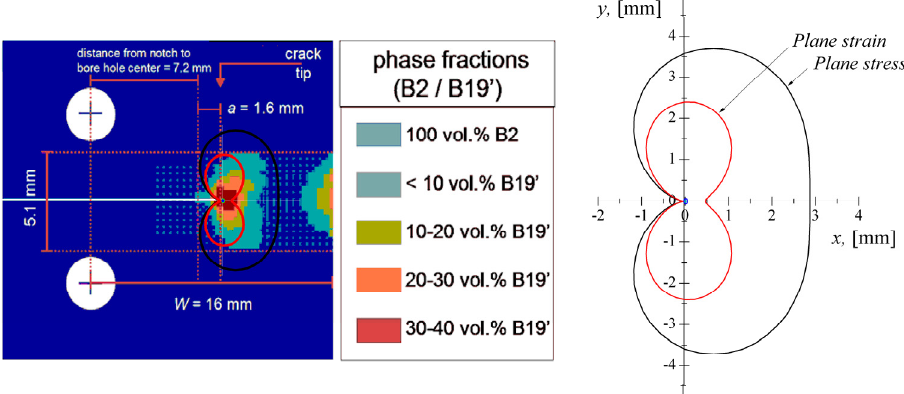
Figure 5: Comparison of the crack-tip transformation region between numerical predictions and experimental observations by synchrotron X-ray microdiffraction observations